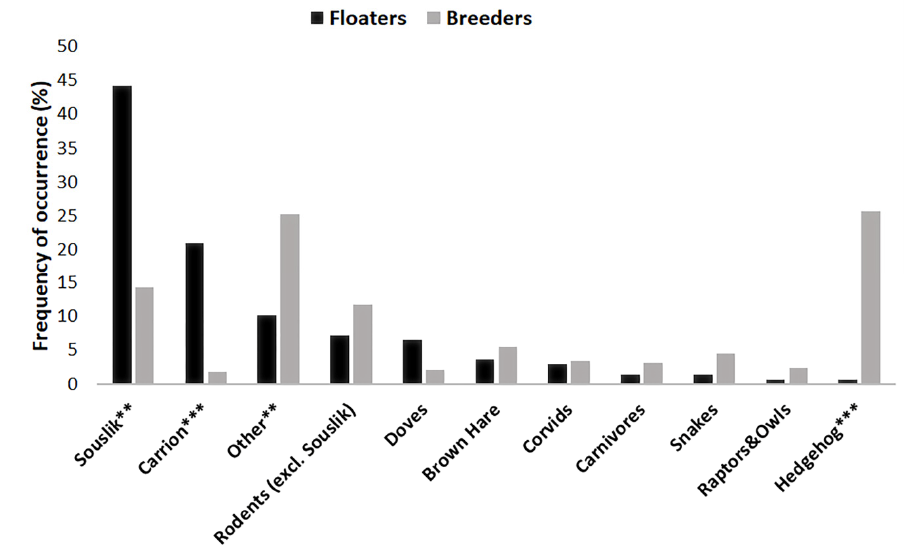
Figure 2. Comparison of prey occurrence in the diet of floaters and breeders of Eastern Imperial Eagle in Bulgaria. Data for breeders (territorial pairs) were taken from [10]. Significant values are given in *.